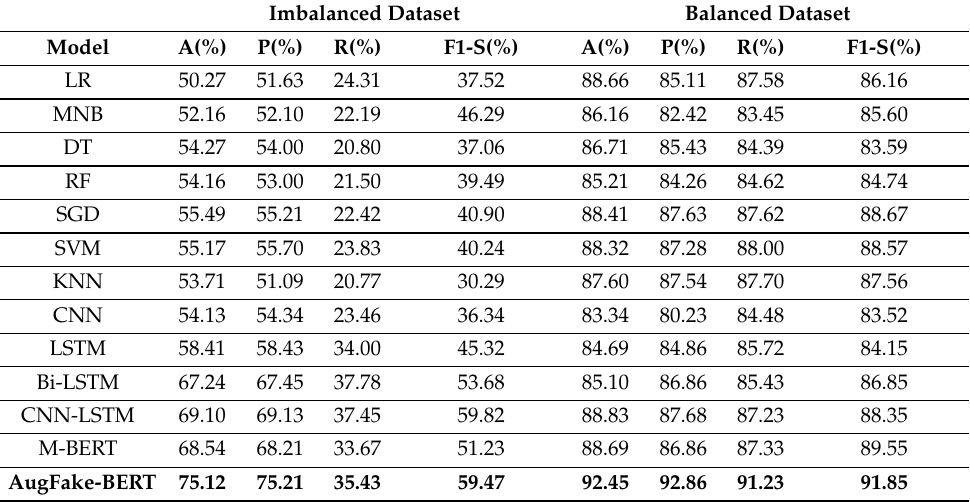
Table 13. Performance metrics of the classifiers on the balanced and imbalanced